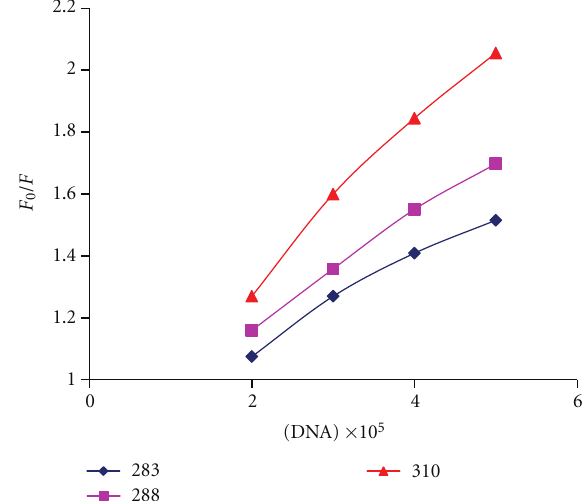
Figure 6: Plots of F 0 /F versus [ Q ] for the binding of Pt(II) complex with CT